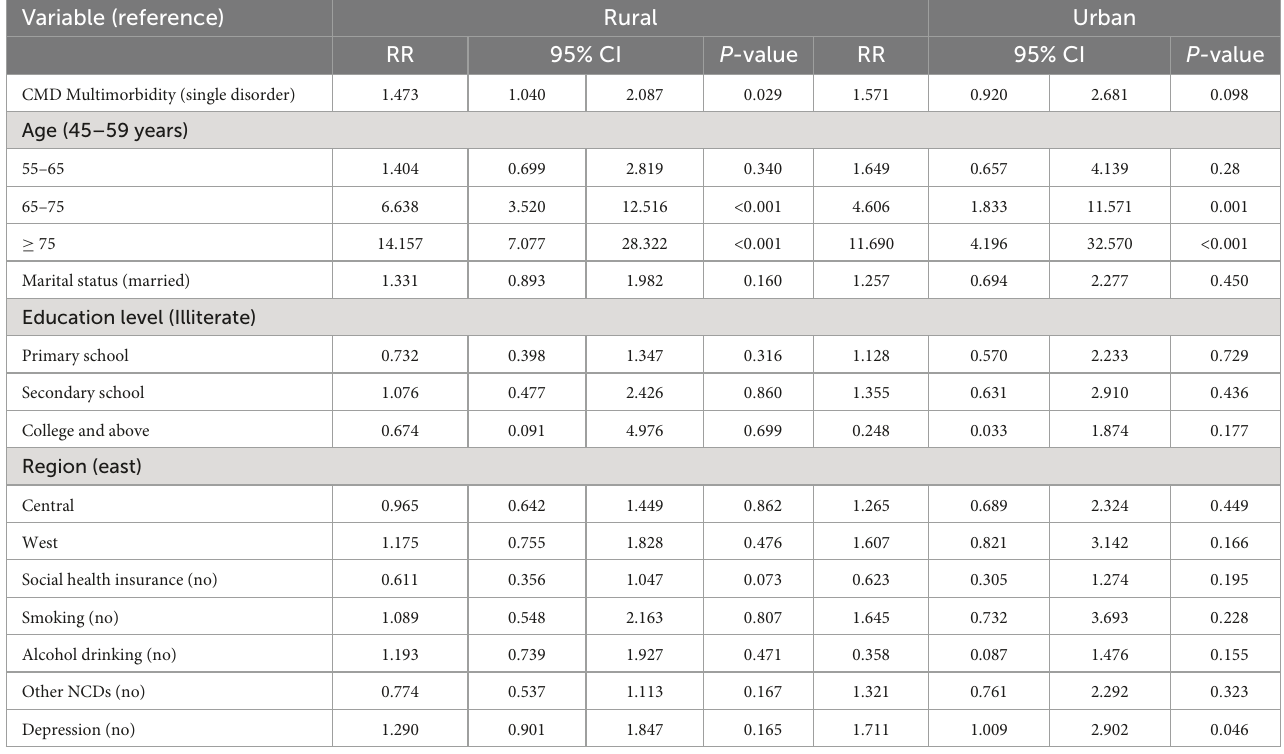
TABLE 4 Association of CMD multimorbidity with all-cause death among participants living the rural and urban area. Variable